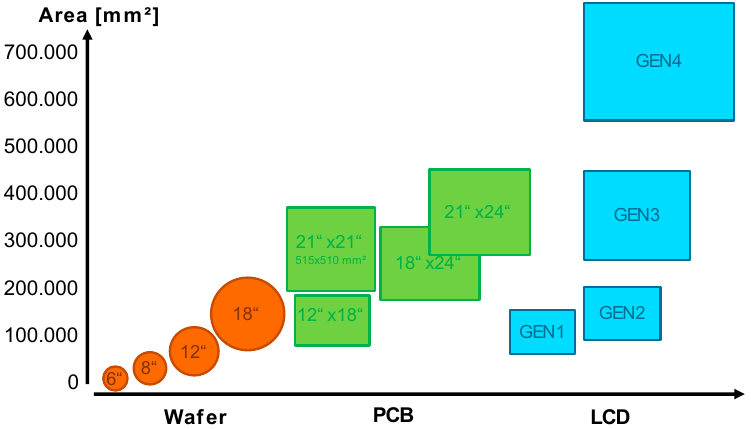
Figure 1. Existing wafer and panel sizes influencing fan-out panel level packaging developments.